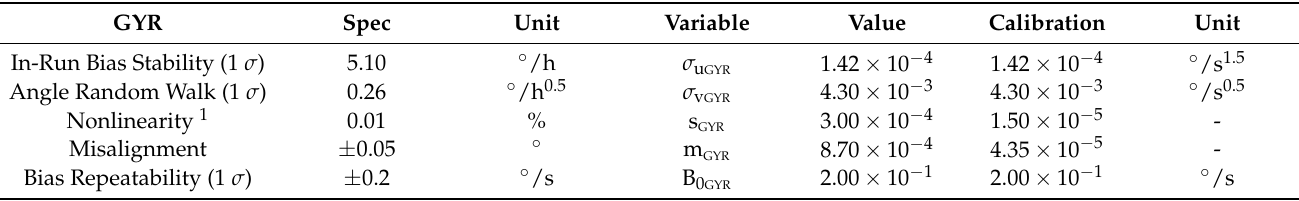
Table 14. Example for gyroscopes performance